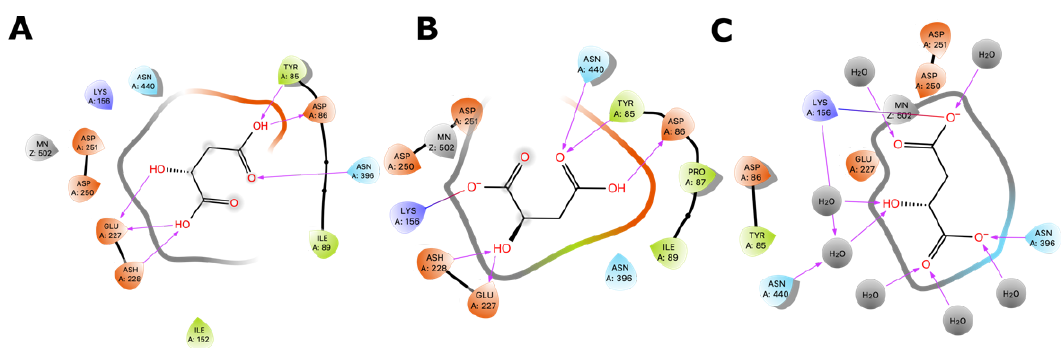
Figure 8. ( A ) L -Malic Acid and ( B ) L -Malate − 1 and ( C ) L -Malate − 2 pose into the MLE binding site Figure 8. ( A ) l -Malic Acid and ( B ) l -Malate − 1 and ( C ) l -Malate − 2 pose into the MLE binding site predicted by the QLPD method. predicted by the QLPD